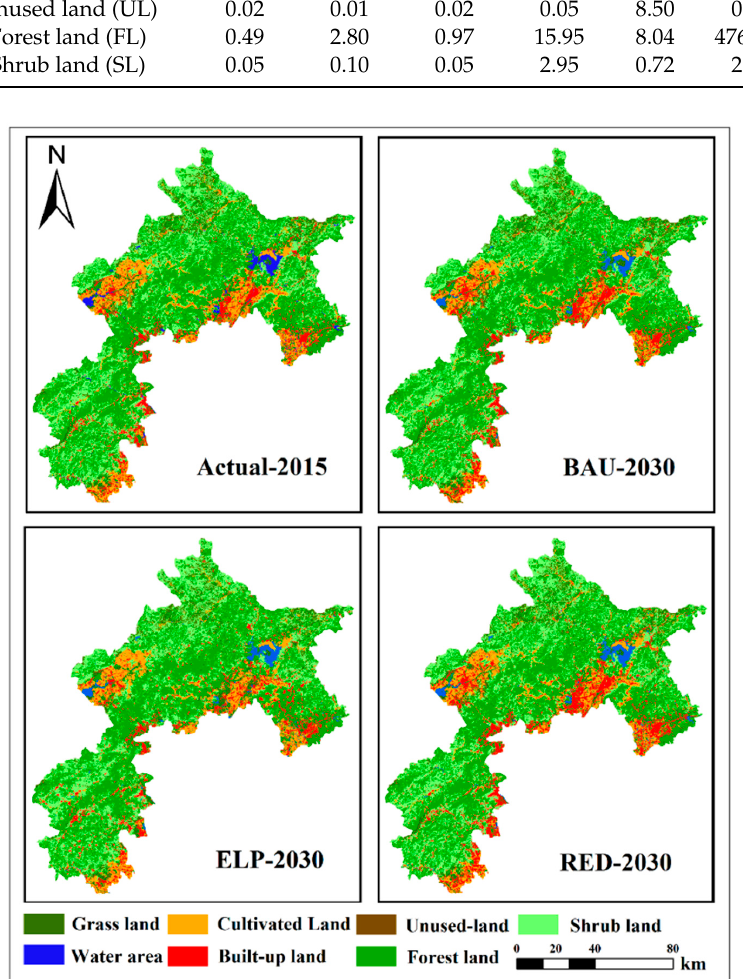
Figure 3. Land-use maps of the baseline year 2015, and 2030 projections under the BAU, RED, and ELP scenarios.